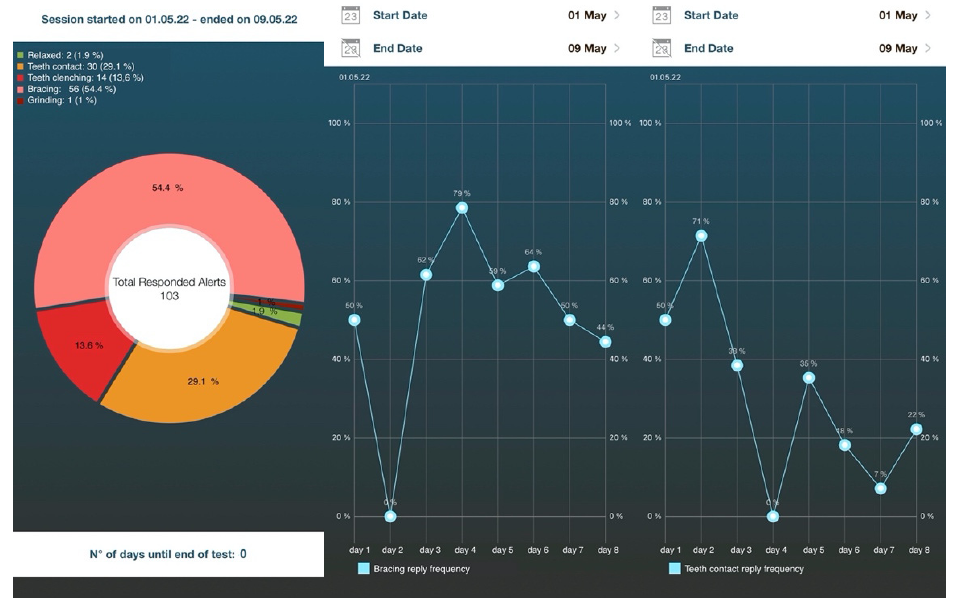
Figure 1. An example graphical interface to report the ecological momentary assessment of awake bruxism behaviors over one week or more. Percentages refer to the frequency of each specific answer over a one-week period and their trend day by day.